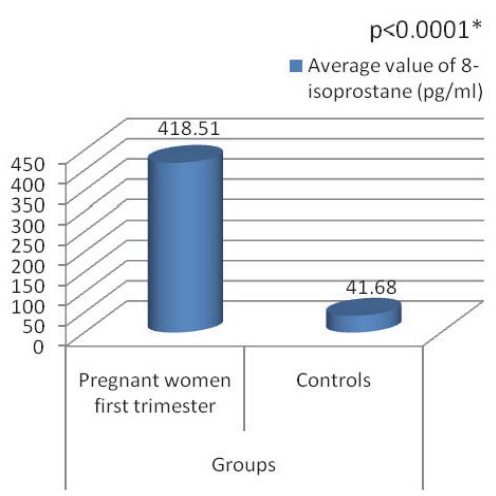
FIGURE 2. - 8 - isoprostane average values for the fi rst tri- mester pregnant women and the control *p – signi fi cancy (if p<0.05 then there is signi fi cant correlation between investigated parameters)